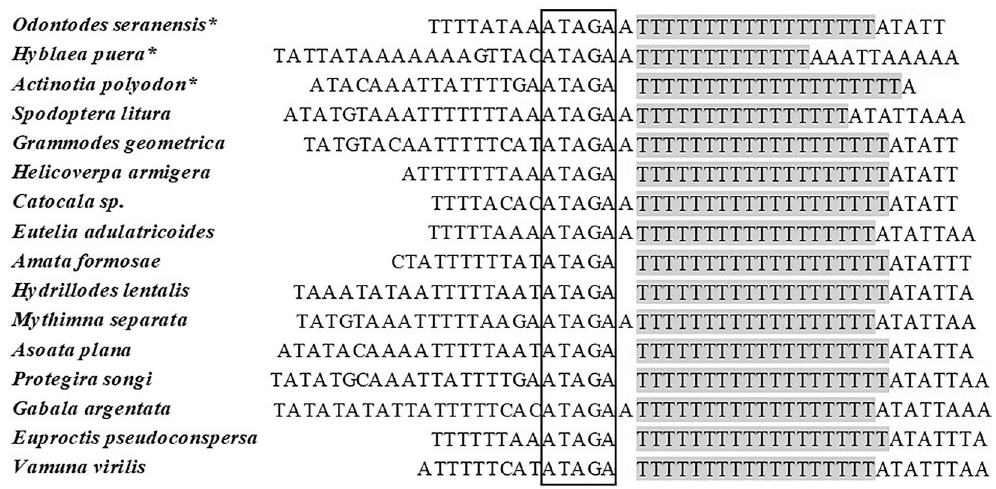
Figure 3. Alignment of initiation site for A + T-rich region of 16 species completely sequenced lepidopteran mitogenomes. The boxed nucleotides indicate the conserved motif ATAGA and the shaded nucleotides indicate poly-T stretch. * newly sequenced mitogenomes presented in this